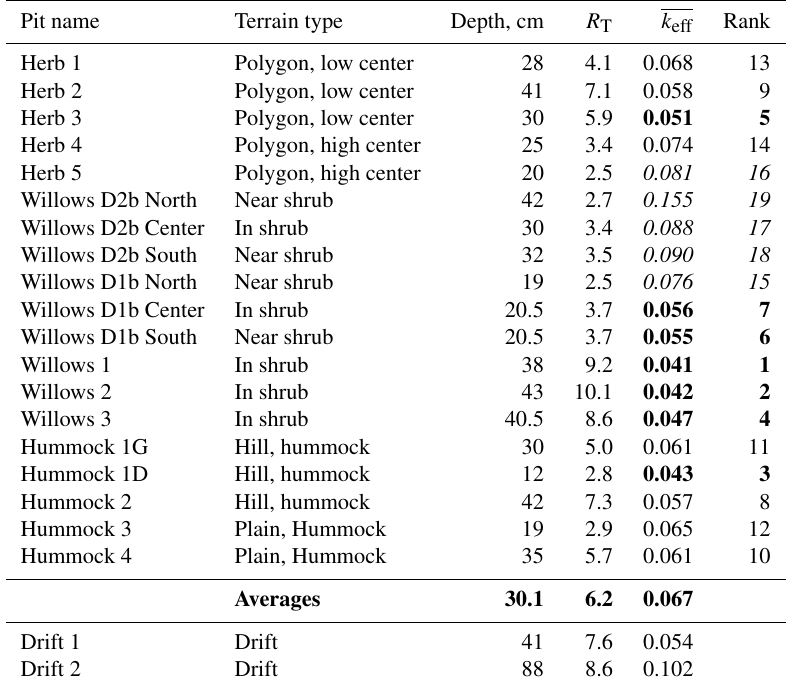
Table 2. Some thermal characteristics of the snow pits studied in May 2015. R T and k eff have SI units. Values of k eff are ranked from lowest to highest. The lowest seven values are in bold and the highest five values are in italics. Pits dug in a thick drift are excluded from the